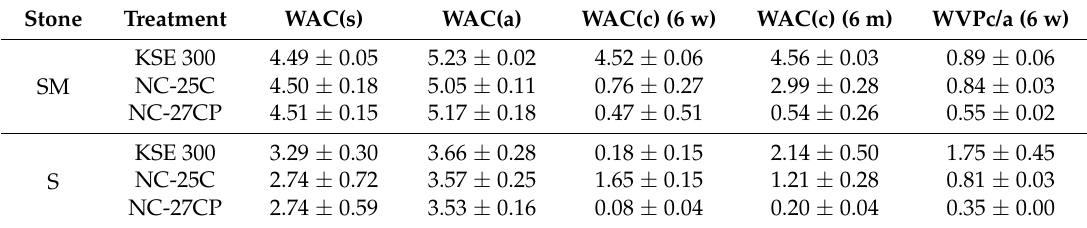
Table 4. Values of water absorption coefficient after one-hour (WAC) [kg · m − 2 · h − 0.5 ] and ratio of